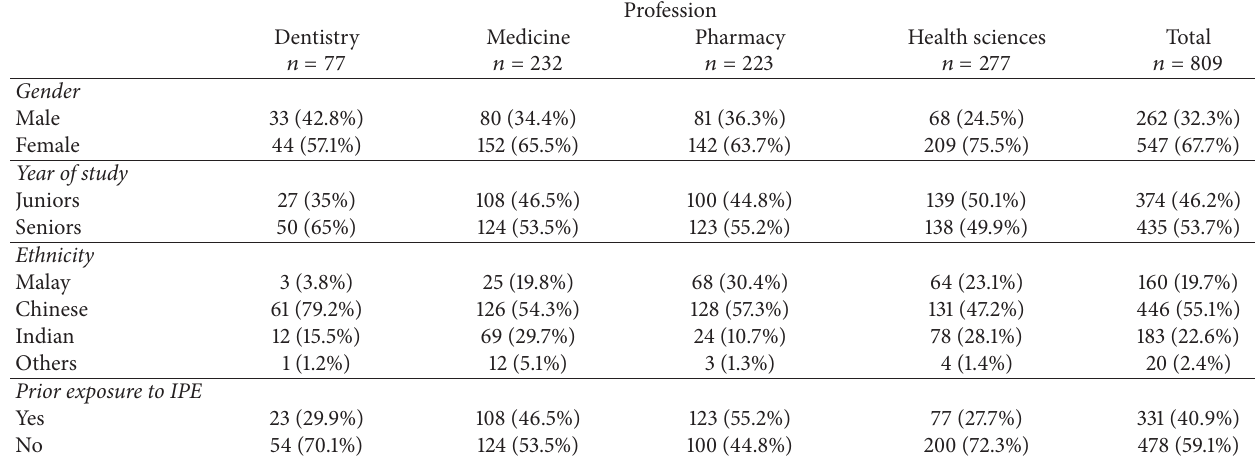
Table 1: Participants and setting.